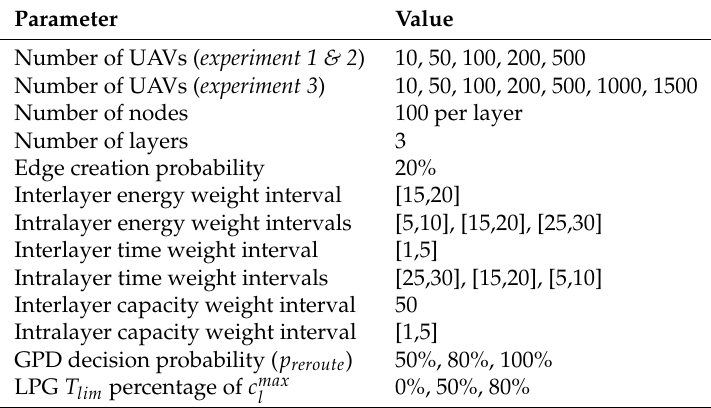
Table 1. Experiment